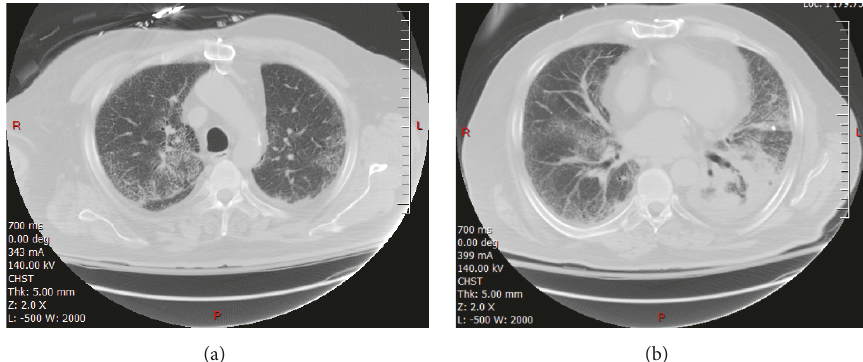
Figure 8: CT images above and at the plane of SBRT treatment showing lung infiltrates and dense consolidation in the left lower lung ((a) and (b) images respectively).